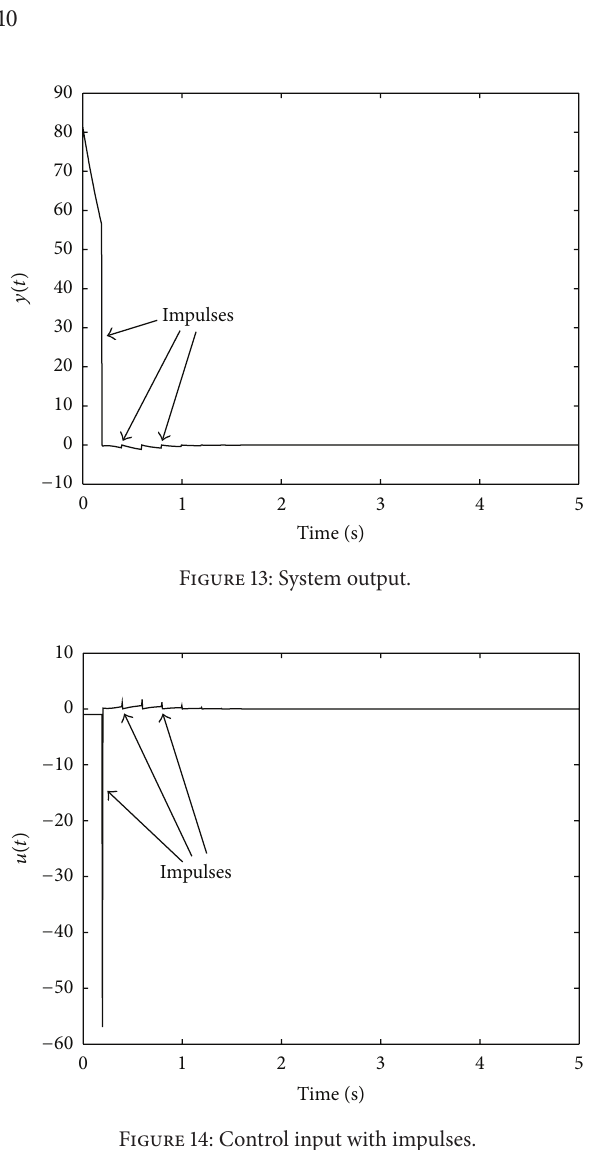
Figure 14: Control input with